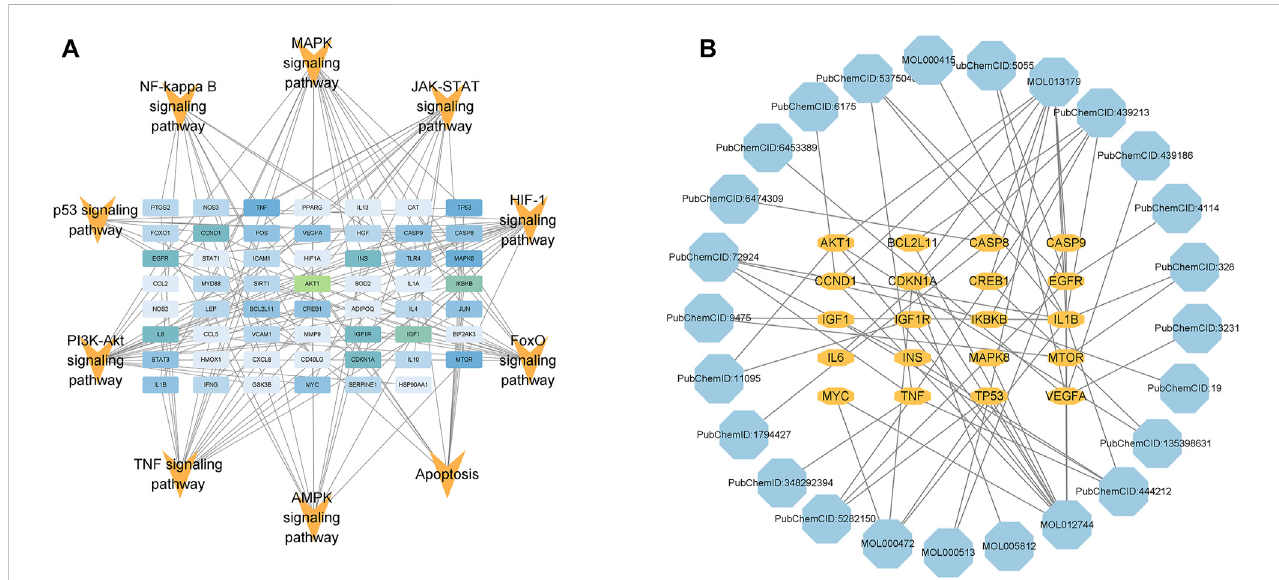
FIGURE 4 Pathway-target and target-component network diagrams. (A) Combined with the pathogenesis of NAFLD, information for 10 pathways and enriched targets was taken for image visualization. (B) Based on the degree values of the targets in Figure (A) , the top 20 targets and the corresponding component information were taken for image visualization (the color of the compounds changes from light to dark according to the degree